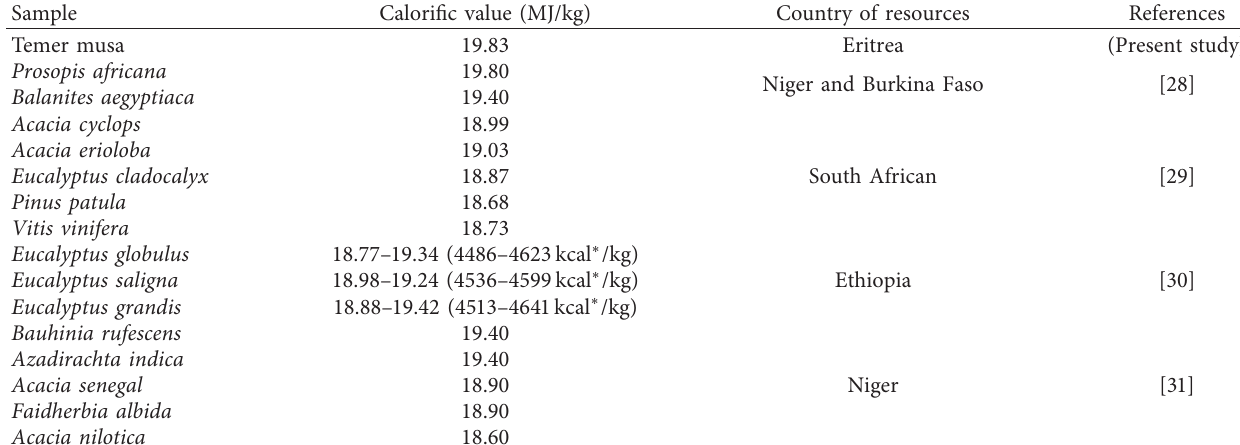
Table 1: Comparison of the calorific value of different trees from different parts of